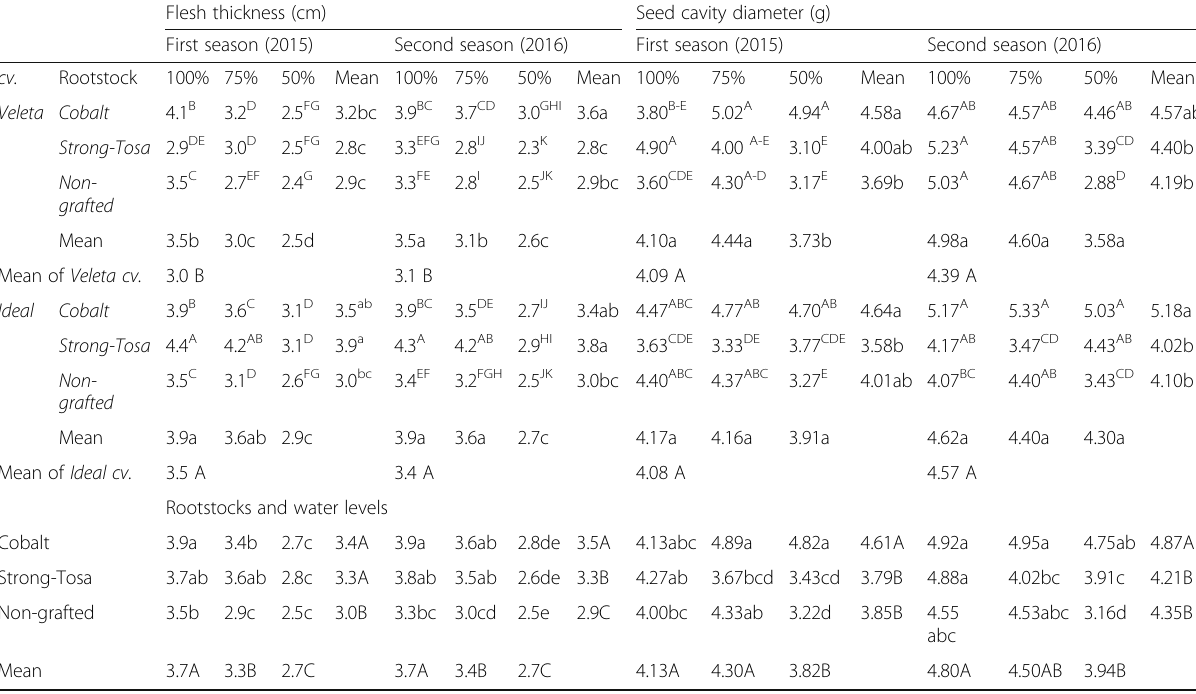
Table 2 Effect of deficit irrigation rates, cultivars and rootstocks on flesh thickness (cm) and seed cavity diameter of fruit for cantaloupe plants during 2015 and 2016 seasons